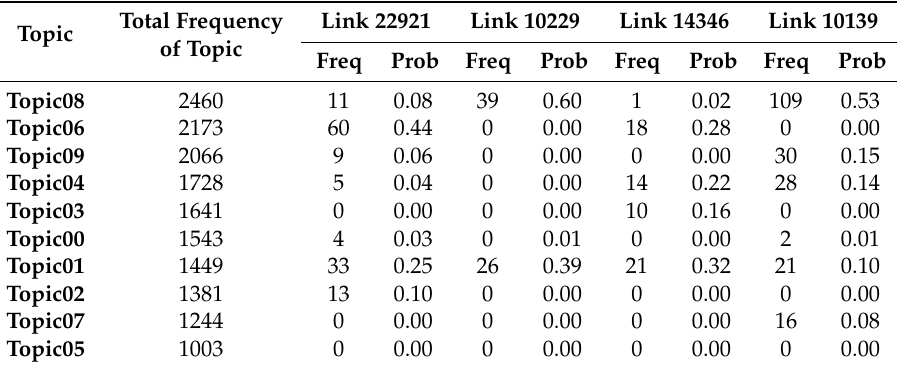
Table 4. Latent Dirichlet Allocation (LDA) results: trip destination significance in topics. Freq and Prob stand for frequency and probability,